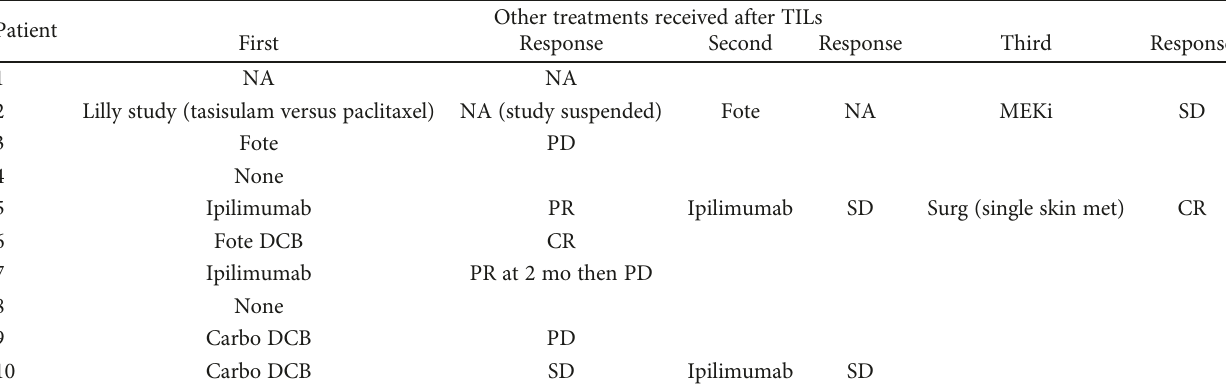
Table 5: Other treatments received after